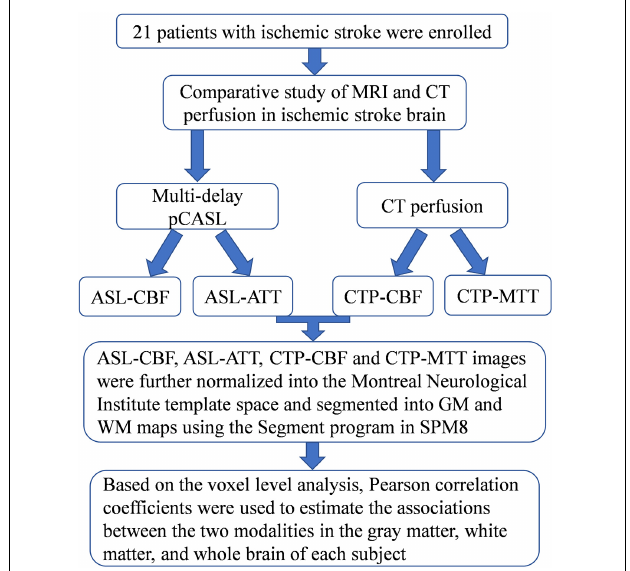
FIGURE 1 | Flowchart of the comparison between ASL and CT